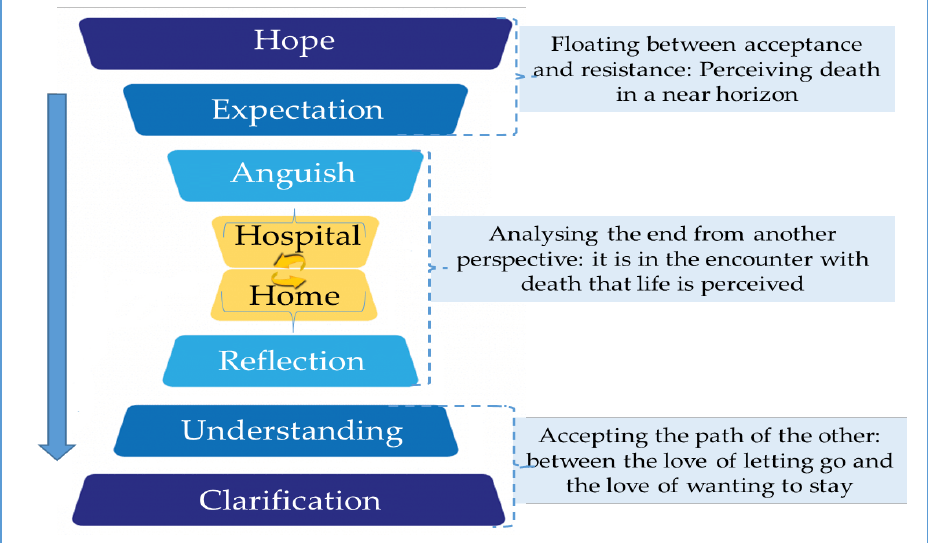
Figure 1. Representative diagram of the terminally ill process during hospital-to-home